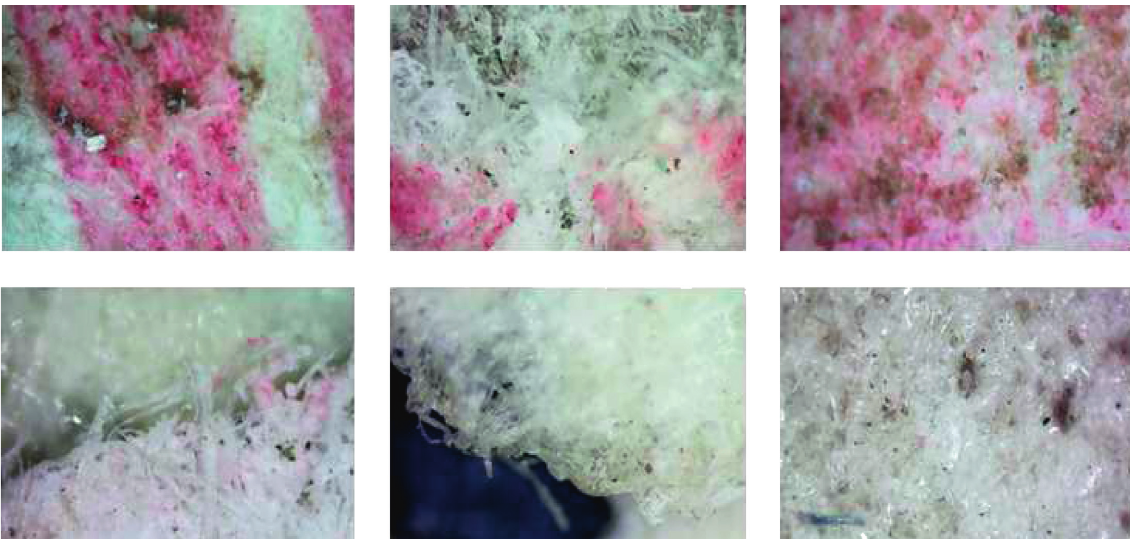
Figure 4: Various tears and spots on the blue stamp and the weakness of the outer part (serrated margins) at 10X.